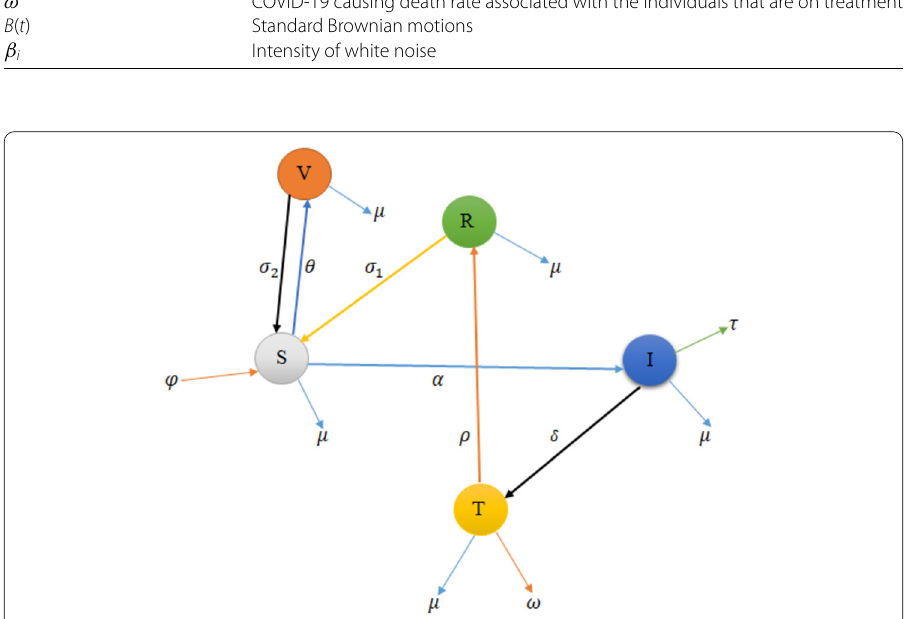
Figure 1 Schematic diagram of COVID-19 model